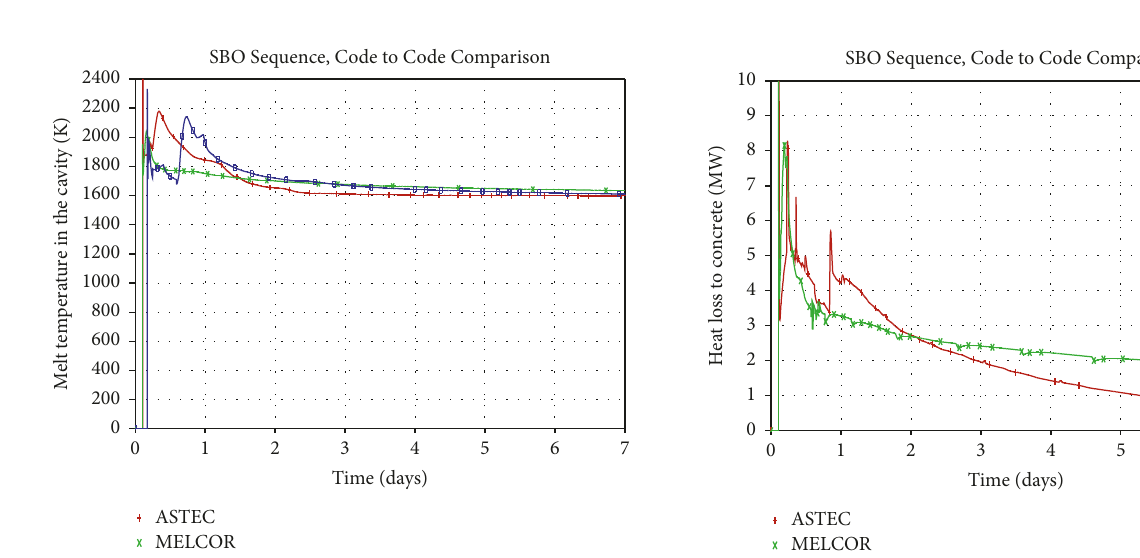
Figure 19: Temperature in the cavity compartment.